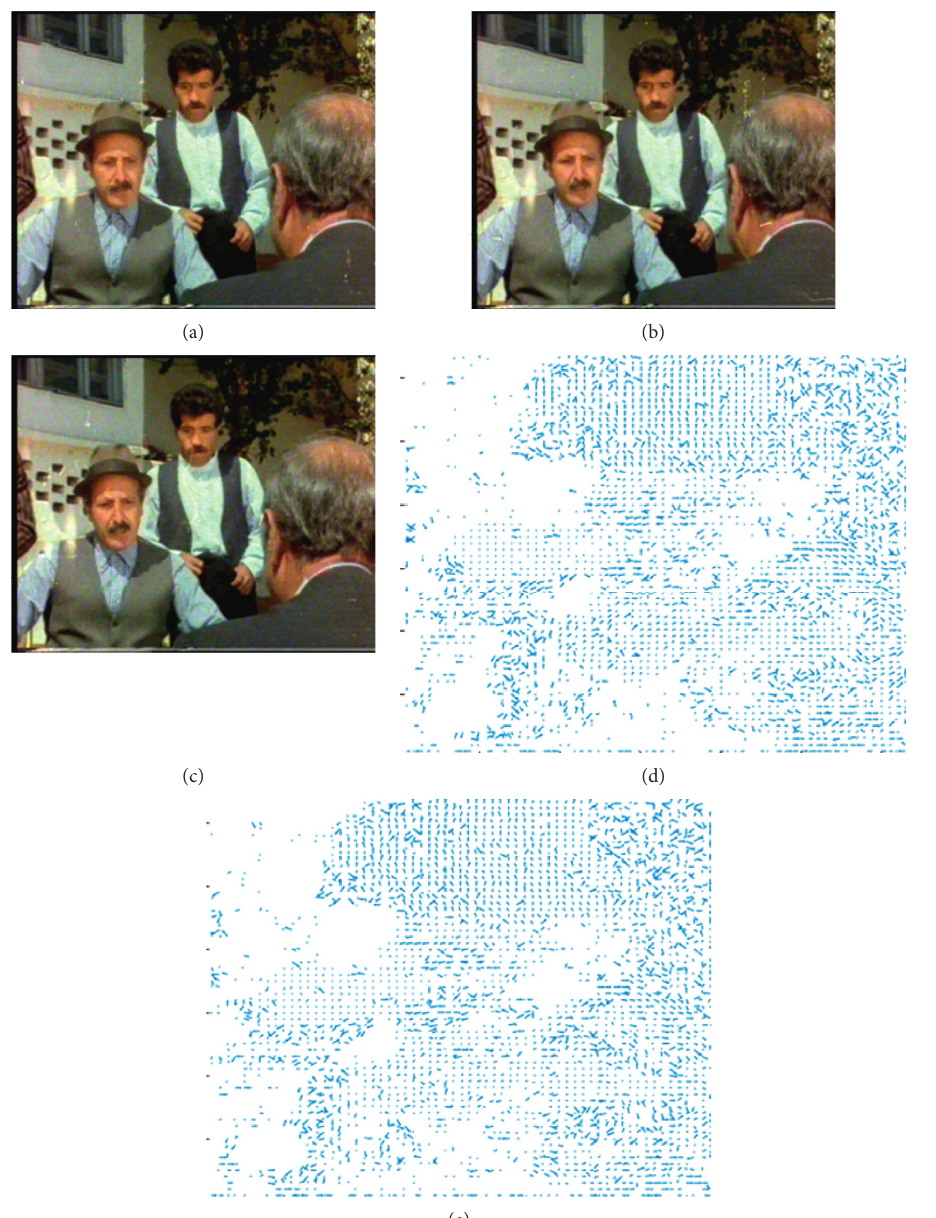
Figure 3: Motion estimation using the algorithm in [9] for an archive film: (a) previous frame, (b) current frame, (c) next frame, (d) backward motion vectors, and (e) forward motion